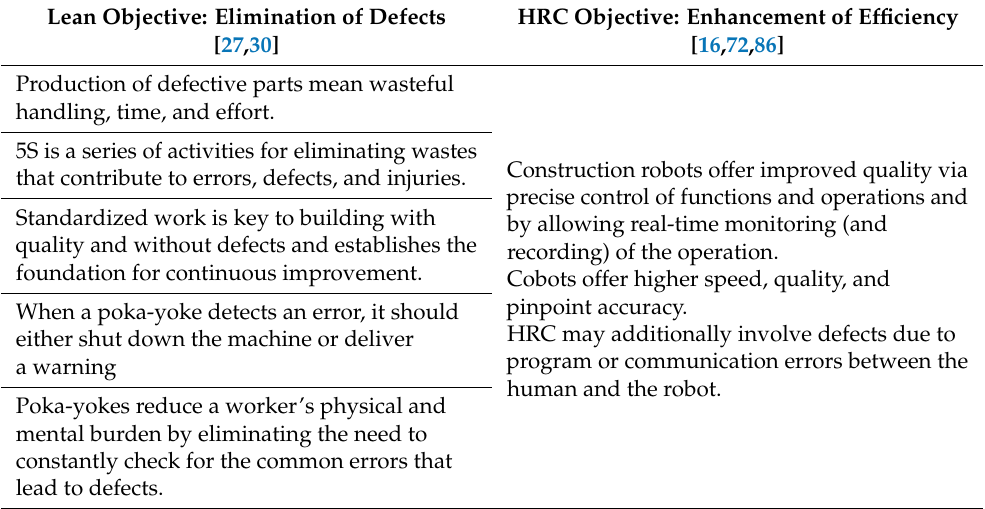
Table 4. Comparison of scope between lean’s goal of defect elimination and HRC’s goal of im- proved